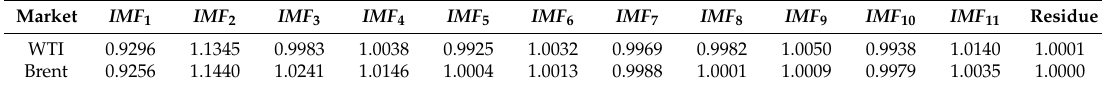
Table 17. Weights of components in aggregation using